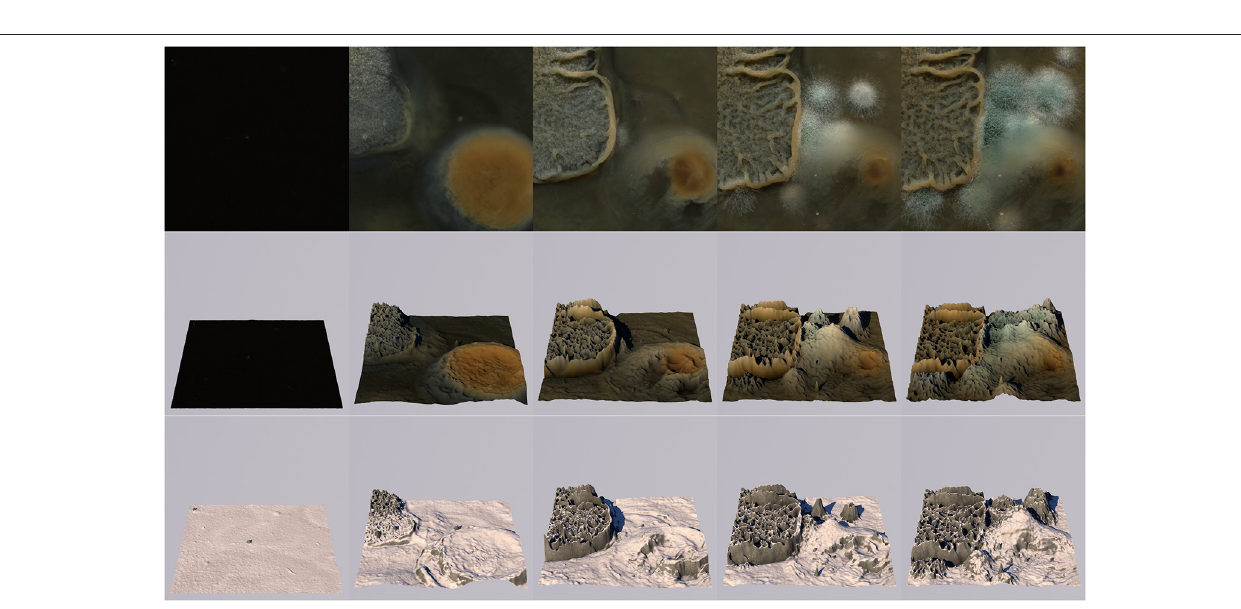
FIGURE 9 | Another example of five stages of the growth process with roughly 2-day intervals. Columns (temporal stages) and rows (scans and generated terrains) depict the same parameters as in Figure 8 , but for another microbial